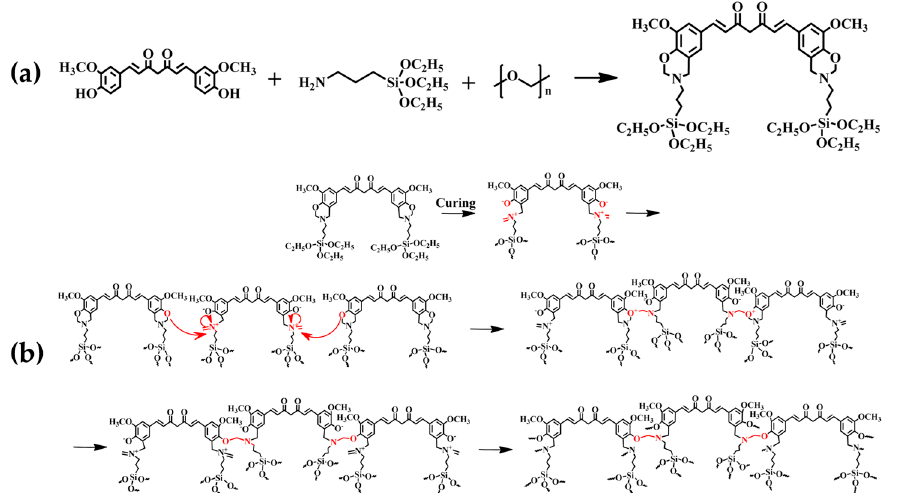
Figure 20. Curcumin-based benzoxazine monomer synthesis reaction ( a ) and synthetic pathway for the curcumin-based benzoxazine polymerization through thermal induction of ring opening ( b ). Reprinted with permission from Ref. [73]. Copyright 2021, Y. Deng, Composites Part B: Engineering, Elsevier.